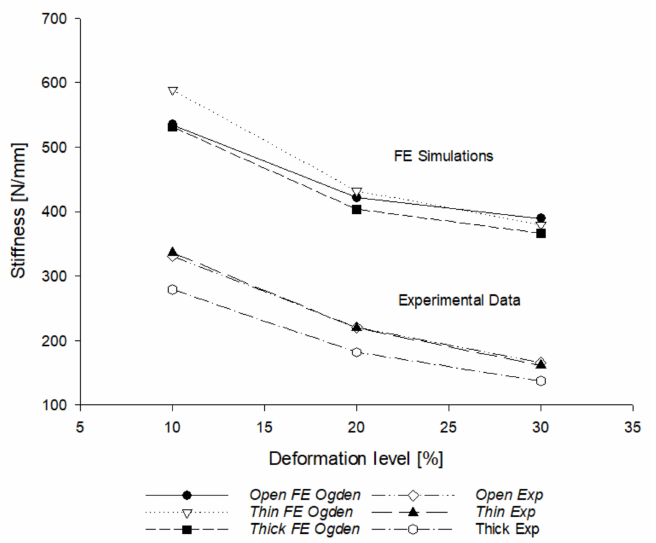
Figure 11. FEM Ogden model vs. experimental results.